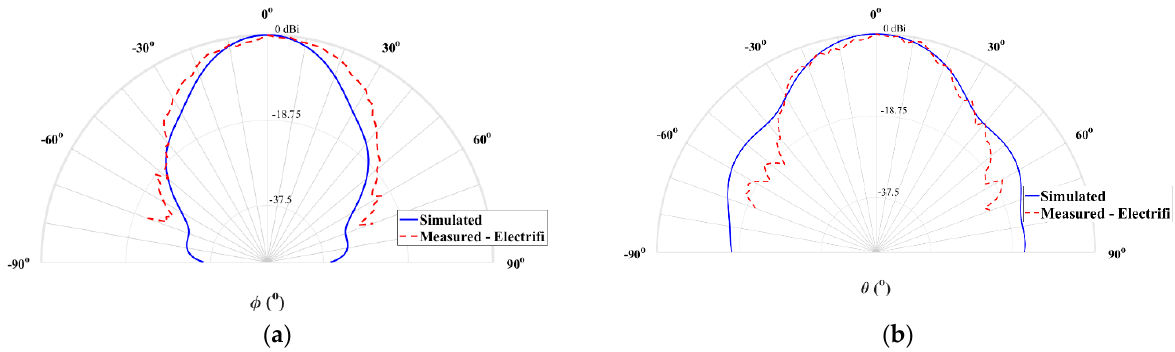
Figure 13. Simulated and measured normalized radiation pattern at 28 GHz of the 3D-printed horn antenna with conductive filament: ( a ) plane θ = 90° and (b) plane ϕ = 90°.